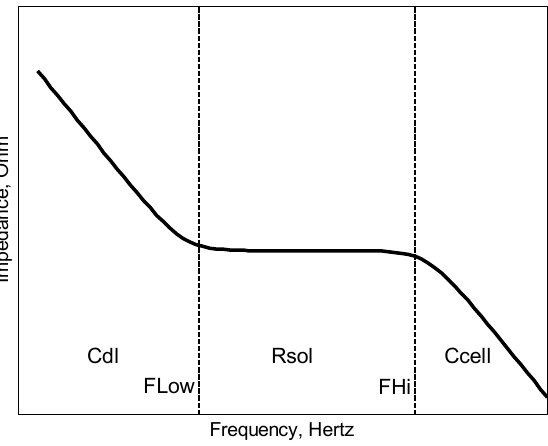
Fig. 3: Diagram of total impedance vs. frequency behavior. Three cases can be distinguished: For low frequencies (before F Low ), the total impedance only depends on the double layer capacitance C DL . In the intermediate range the impedance reaches a plateau, which depends on the solution resistance R Sol . For high frequencies (after F Hi ), the impedance depends on the cell capacitance C Cell